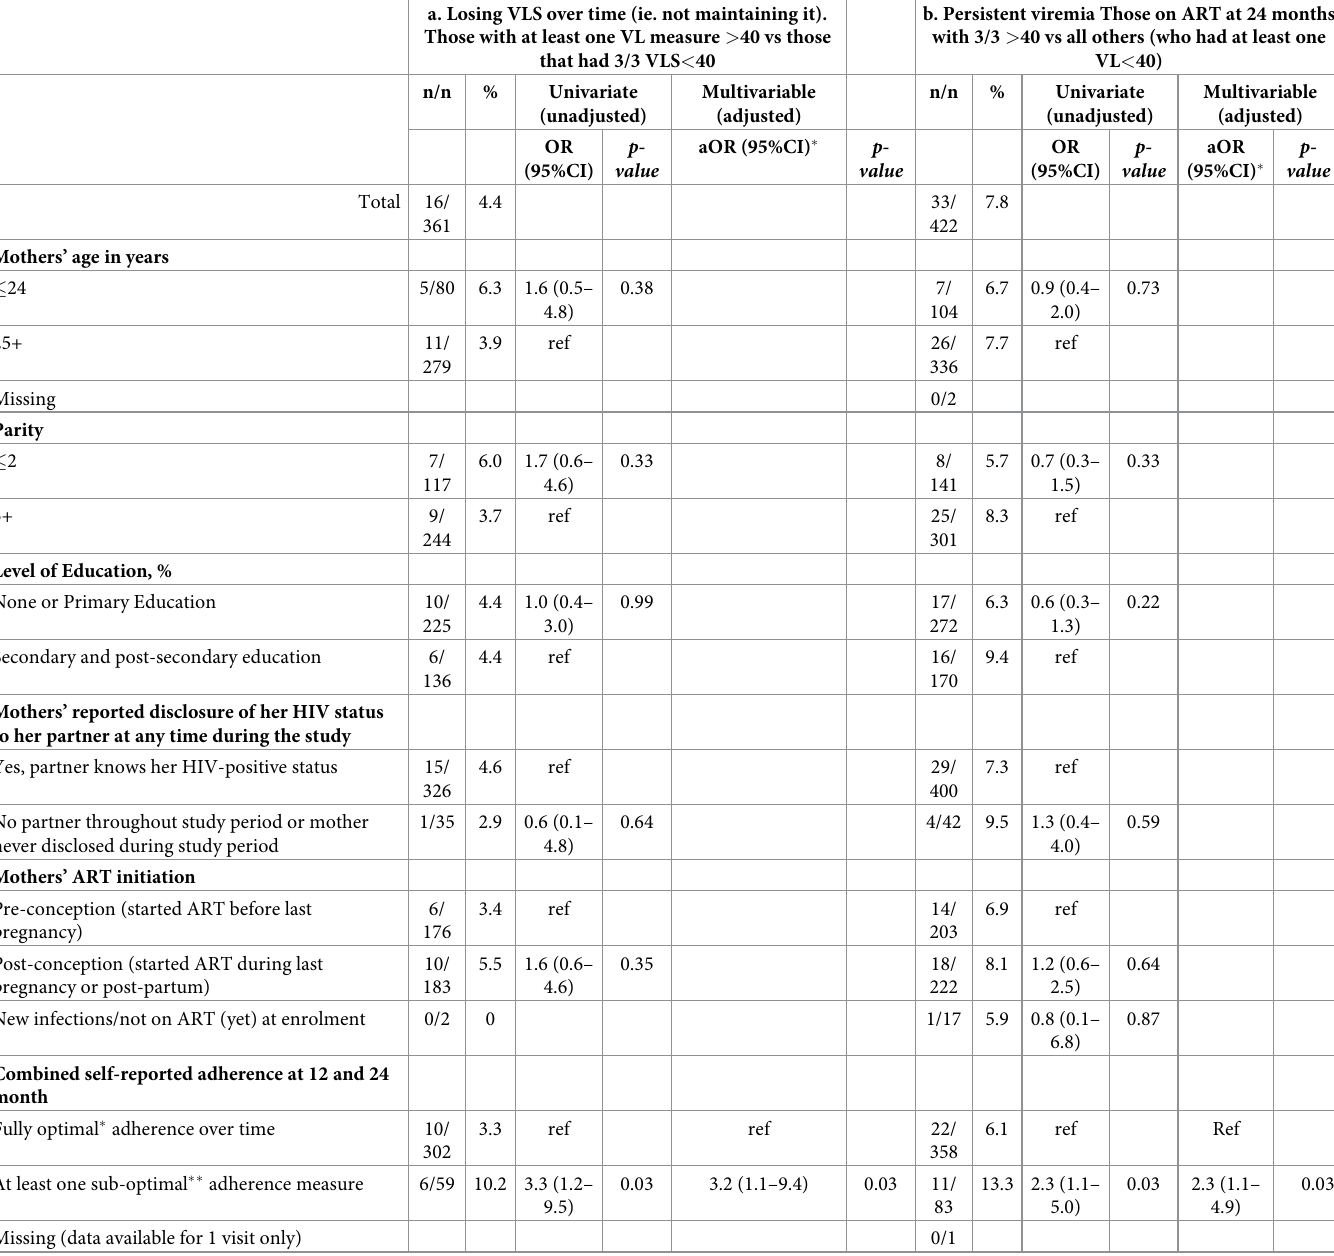
Table 5. a and b Factors associated with experiencing any viremia during the post-partum period and with persistent detectable VL load through the post-partum period. a. Losing VLS over time (ie. not maintaining it). Those with at least one VL measure > 40 vs